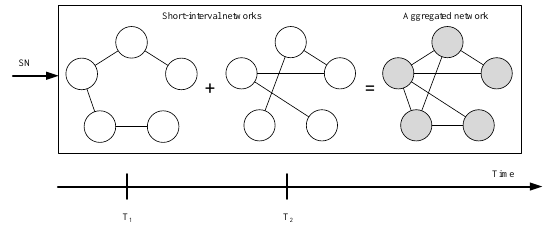
Fig. 2: Illustration of the short-interval networks and aggregated network [41].